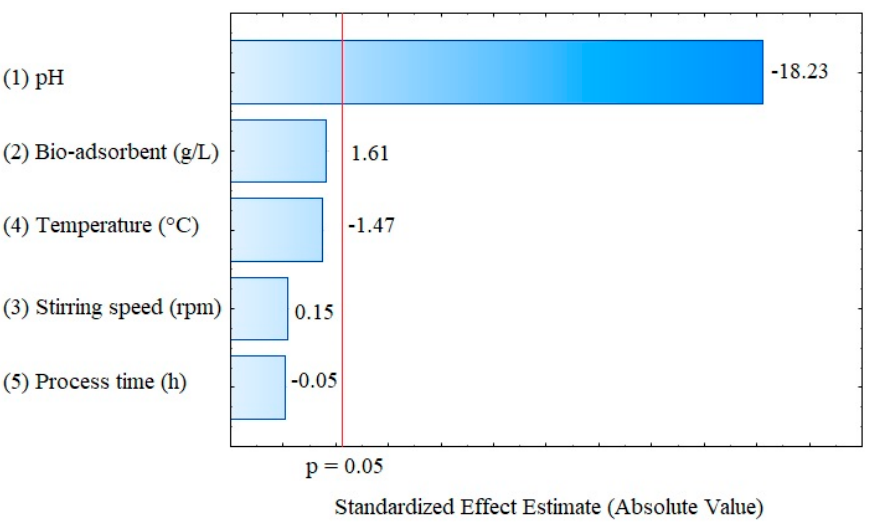
Figure 1. Standardized effects for dye removal from textile wastewater (%) by OS bio-adsorbent.